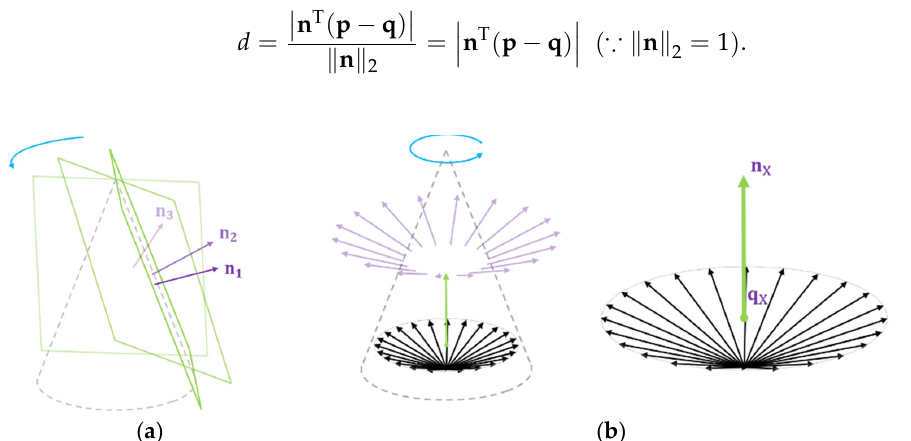
Figure 7. ( a ) The laser plane with an angle to the rotating axis is forming a cone. ( b ) The trace of the normal vector of the rotating plane is forming an inverted cone after starting points of them are moved to a point on the rotating